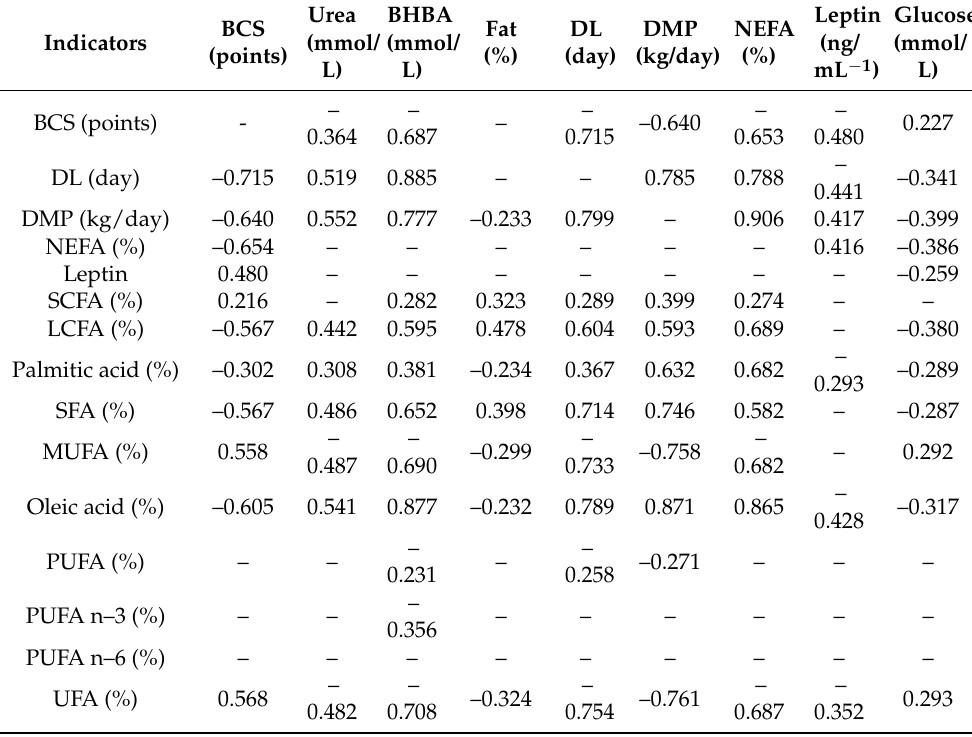
Table 6. Correlations ( p ≤ 0.05) between selected